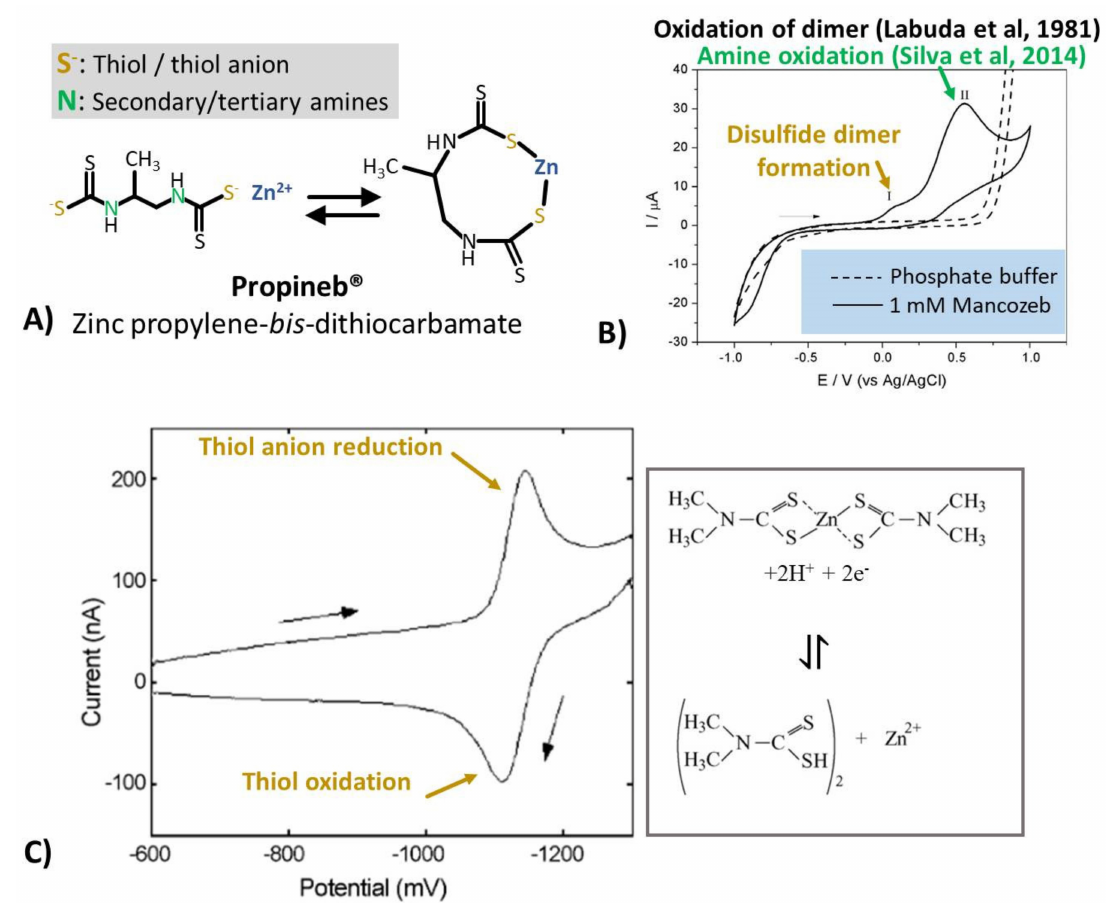
Figure 4. Electrochemical detection of dithiocarbamate pesticides is facilitated by the multiple electrochemically-active moieties they possess. ( A ) Commonly-reported electroactive moieties of dithiocarbamates, using Propineb ® (extracted from [36]) as a general example of this class of compound. ( B ) Cyclic voltammograms of Mancozeb at a Boron-doped diamond electrode in phosphate buffer (extracted from [36]), showing anodic processes involving its thiol and/or amine moieties: two separate possible mechanisms behind the more positive peak are shown, one cited in [36] and that discussed by [35]. ( C ) Cyclic voltammogram of Ziram at a Hanging Mercury Drop Electrode in Britton–Robinson buffer, pH 2.8 (extracted from [37]. Peaks are attributed to the reversible reduction of the thiol moieties and subsequent displacement of the zinc moiety (inset, from same reference) at mercury electrodes. Reproduced from [36,37], by